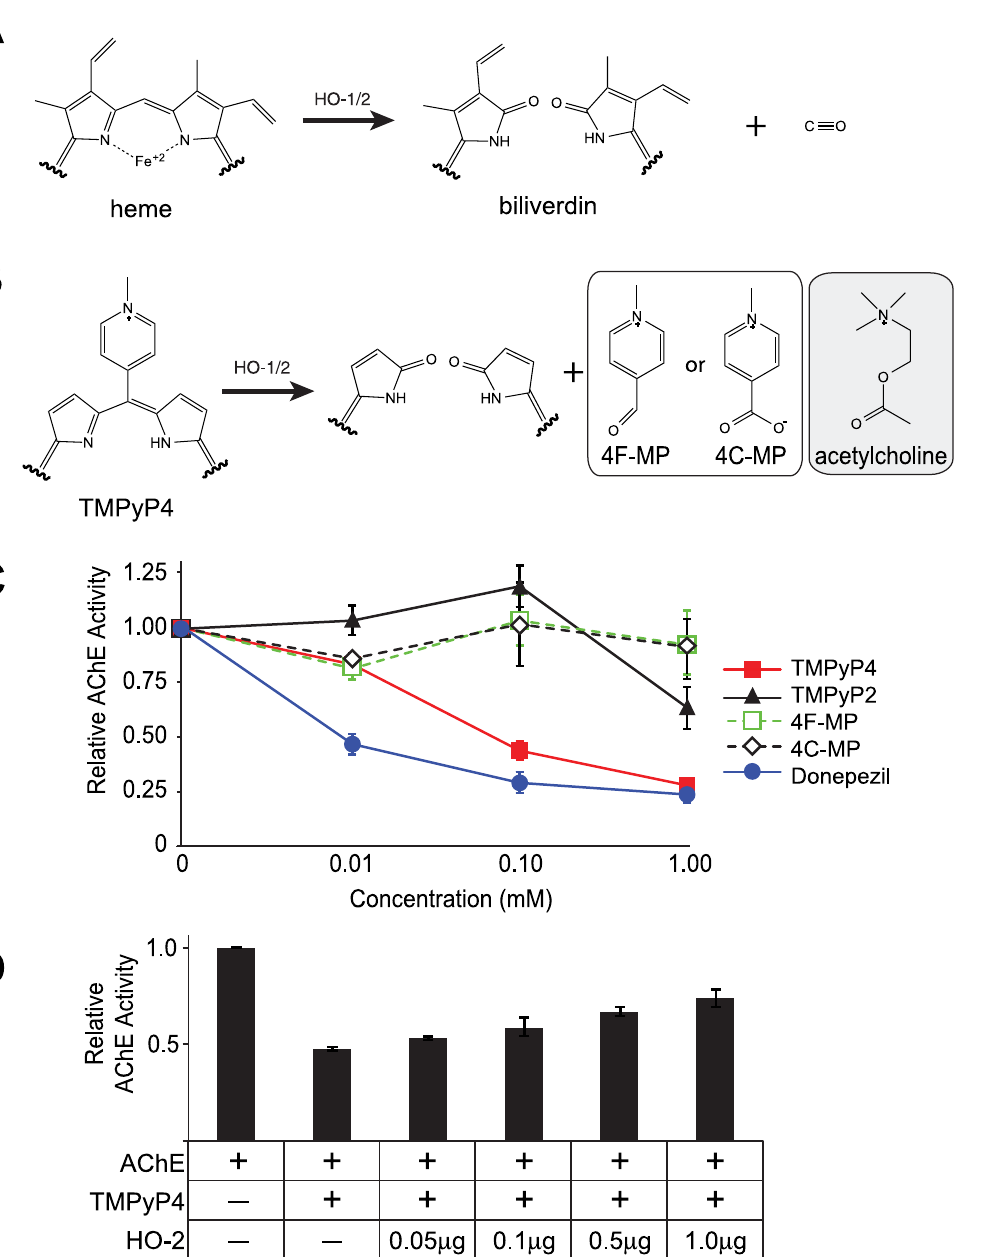
Fig 3. TMPyP4 inhibits AChE activity. A , oxidation of heme by Hemeoxygenase (HO) enzymes produces biliverdin and carbon monoxide. B , oxidation of TMPyP4 by HO enzymes is expected to generate either 4-formyl-1-methylpyridinium (4F-MP) or 4-carboxy-1-methylpyridinium (4C-MP). Both 4F-MP and 4C-MP have a structural resemblance to acetylcholine. C , fluorometric assay of AChE activity in presence of TMPyP2, TMPyP4, 4F-MP, 4C-MP and an established AChE inhibitor (Donepezil). D , pre-incubation of TMPyP4 with recombinant HO-2 prior rescued AChE activity in a concentration-dependent